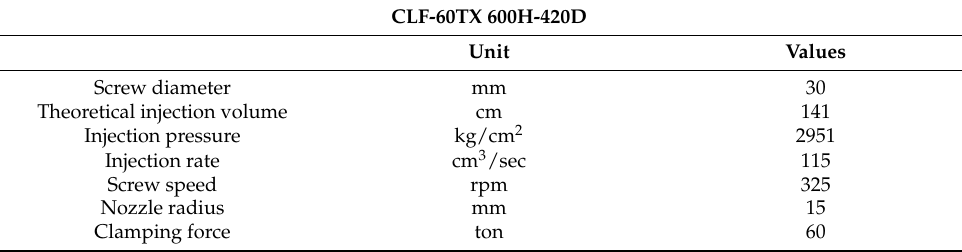
Table 4. Injection molding machine specifications.